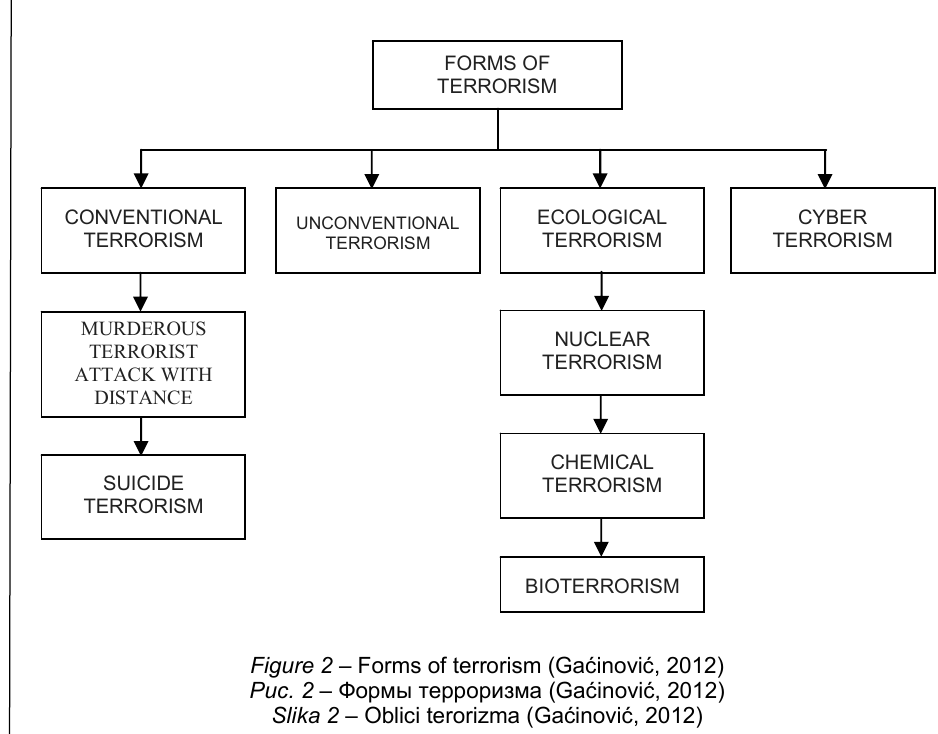
Figure 2 – Forms of terrorism (Ga ć inovi ć , 2012) Рис . 2 – Формы терроризма (Ga ć inovi ć , 2012) Slika 2 – Oblici terorizma (Ga ć inovi ć ,